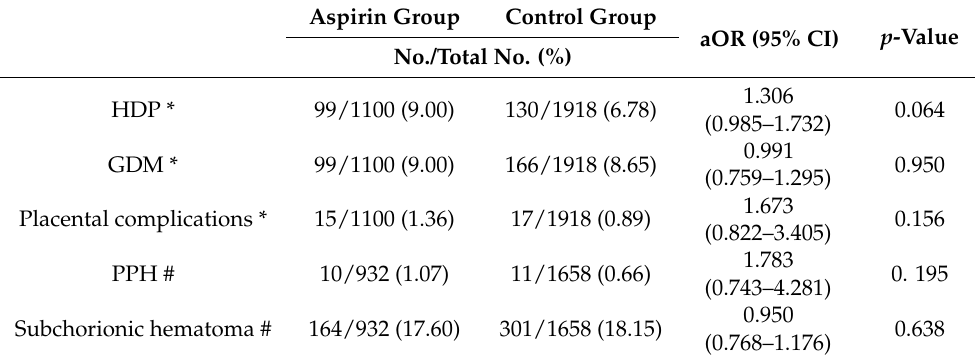
Table 3. Relationships between Aspirin and pregnancy